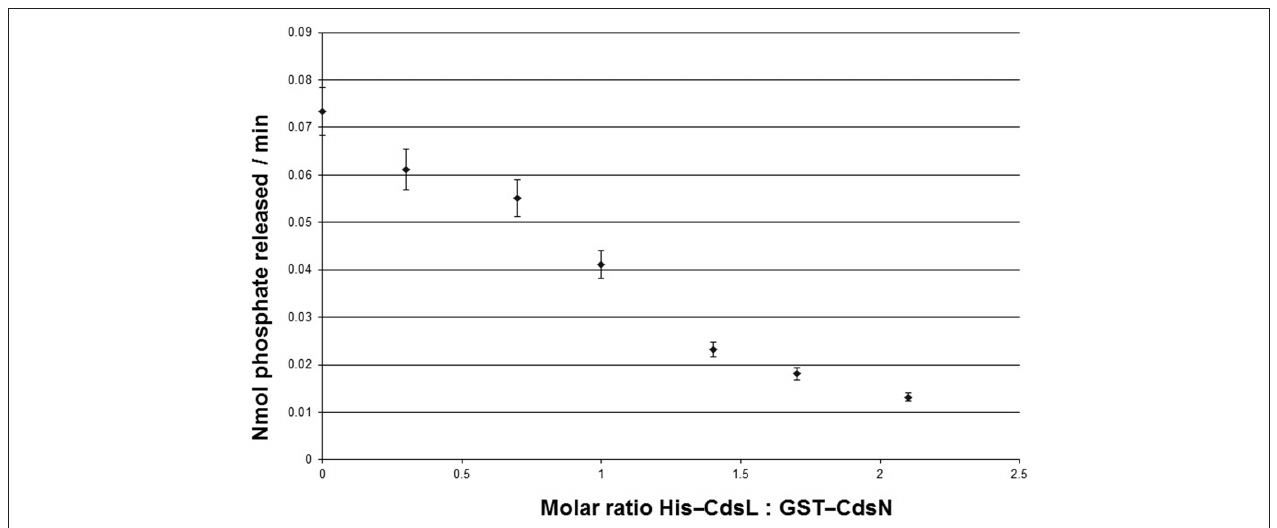
FIgure 1 | CdsL down-regulations CdsN enzymatic activity in a dose- dependent fashion. Aliquots (150 ng) of GST–CdsN were assayed for enzymatic activity using the malachite green assay to detect released inorganic phosphate from ATP. His–CdsL was added to the reaction mixture at molar ratios between 0.3 and 2.1, and ATPase activity of GST–CdsN was measured.